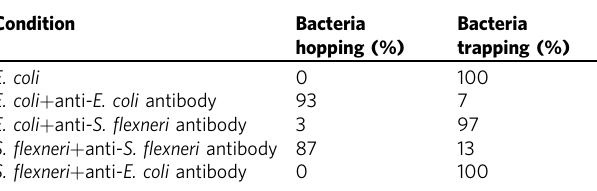
position. The residence time of the aggregated particles is much